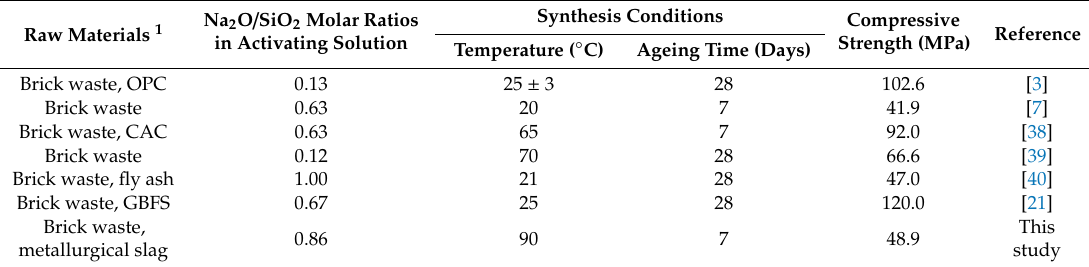
Table 5. Comparison of compressive strength for brick-waste based